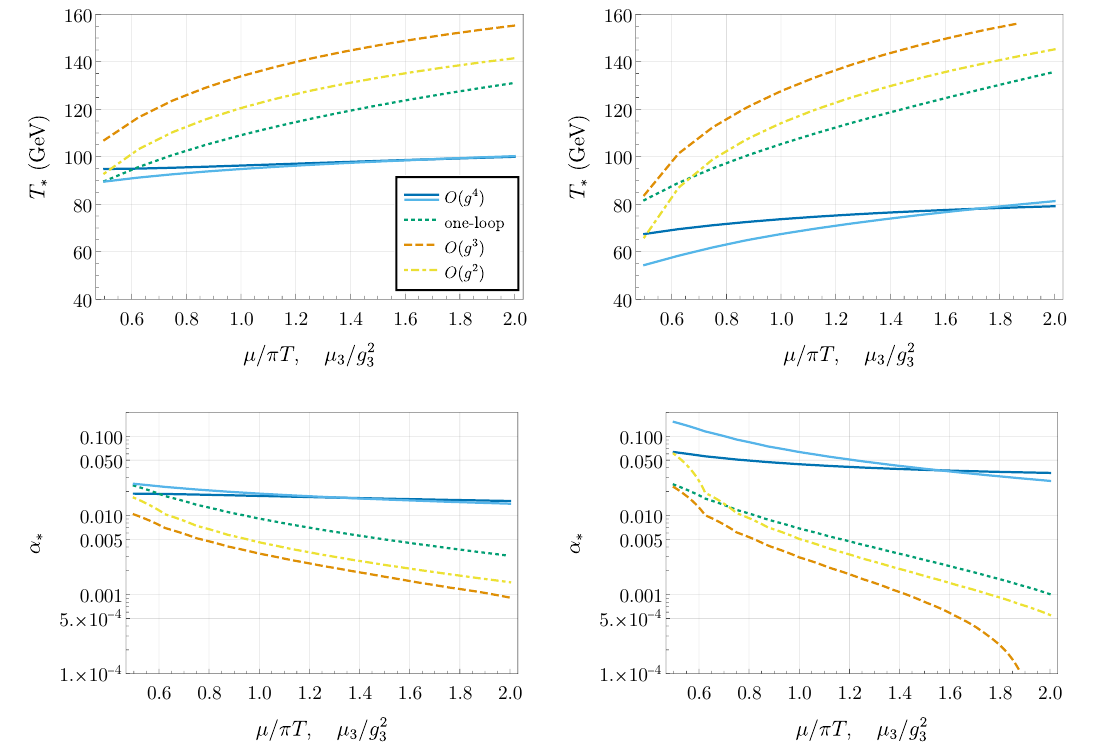
Figure 5. As figure 4 but for T ∗ and α ∗ . The O ( g 4 ) approximation still shows a weaker RG- scale dependence than the other approximations. However, compared to the purely equilibrium quantities in figure 4, dependence on µ 3 is significantly stronger due to the limited O ( ~ 0 ) accuracy of the bubble nucleation calculation. This is especially true for BM2, for which the scalar couplings are